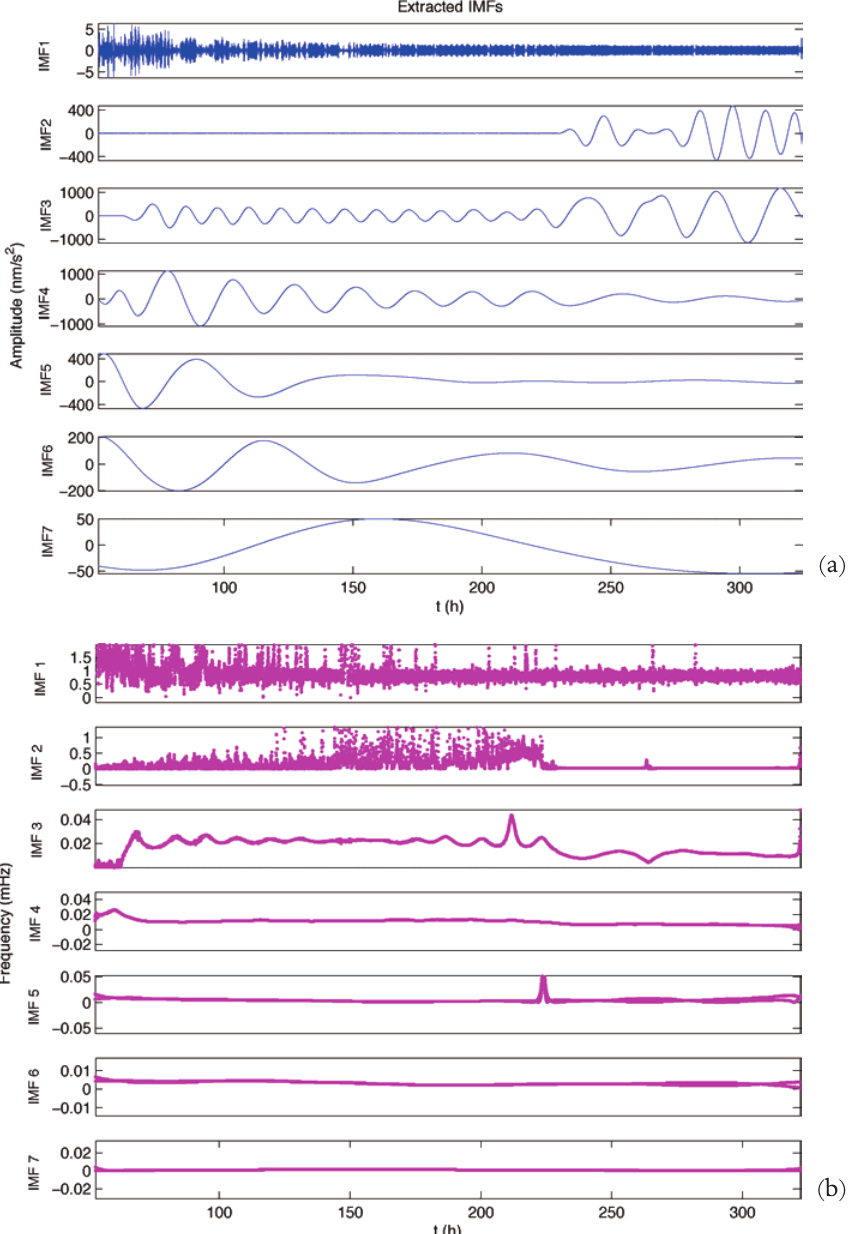
Figure 2. The Hilbert-Huang transformation applied to the SG data following correction for pressure, as recorded at Bad Homberg (H2). (a) Extracted IMFs (1-7) of the SG data based on EMD. (b) Instantaneous frequencies corresponding to each of IMF1-7 of panel